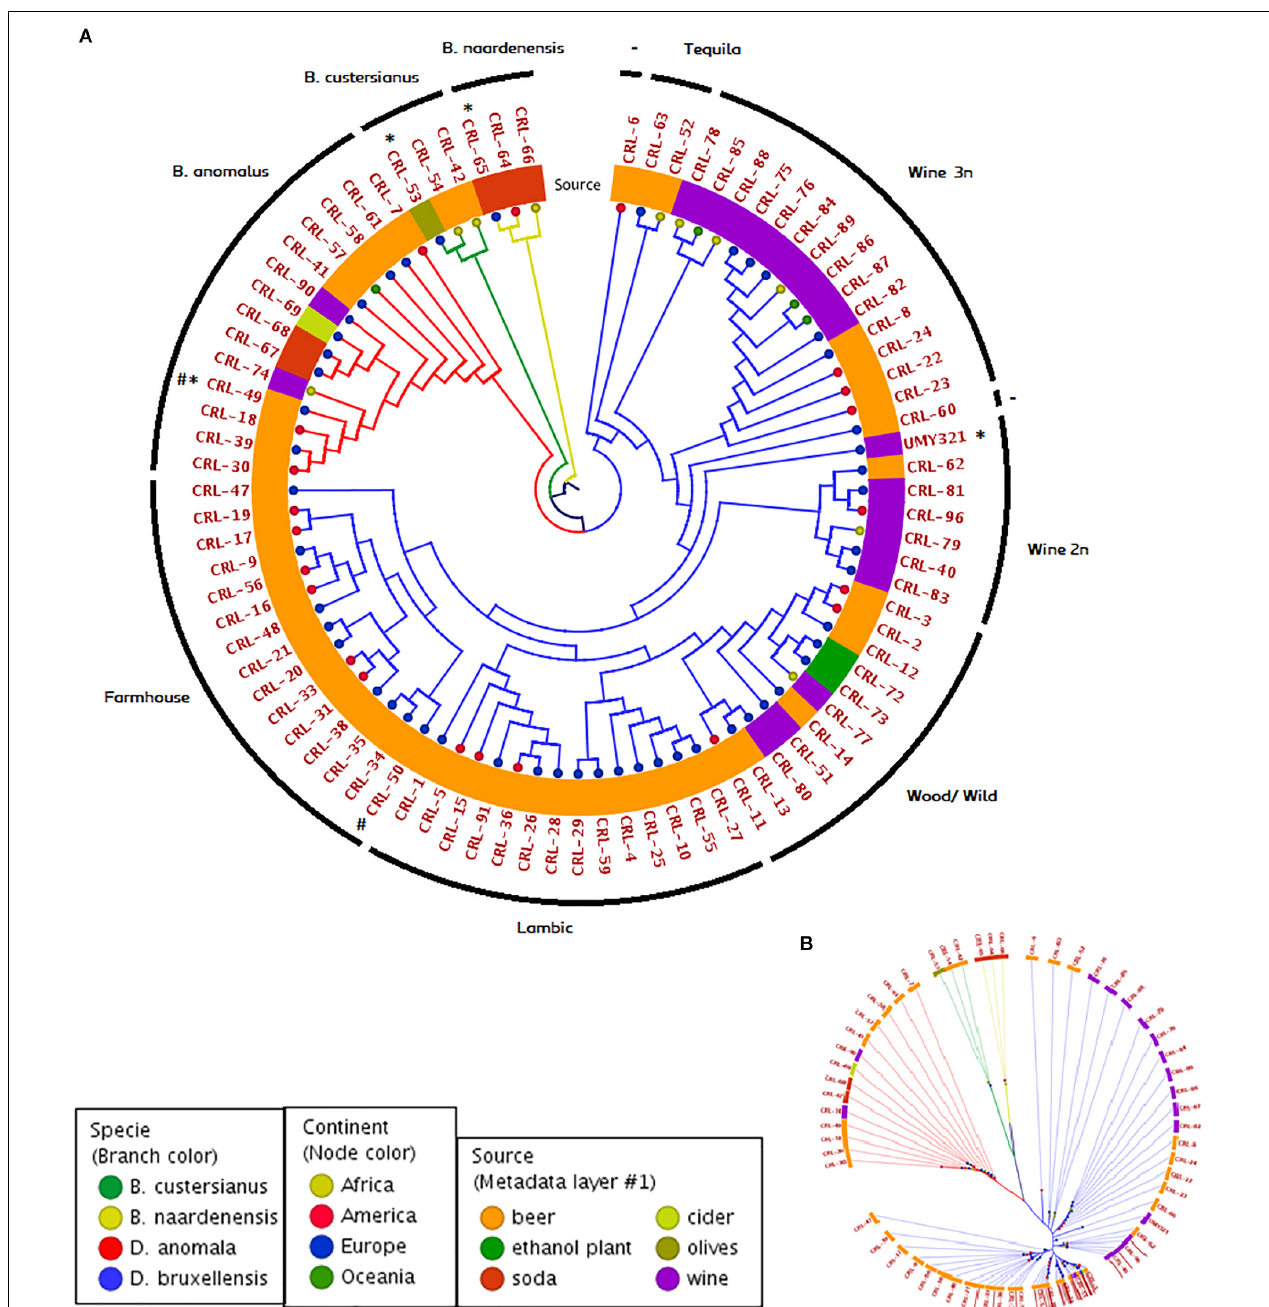
FIGURE 2 | Genomic phylogeny of Brettanomyces population. (A) Circular claudogram of 84 Brettanomyces species included in this study. Phylogenetic tree was produced by comparison of the predicted proteins in the whole genome of each strain. Strains used as reference genome are marked with ( ∗ ) Old CRL isolates are marked with (#). Branches are colored according to species, tree nodes according to continent of origin, and metadata layer is colored according to substrate of isolation. Yeasts have been grouped in different genetic clusters according to its location in the tree and genetic cluster names are indicated in the external circle. (B) Same phylogenetic tree in radial form. Branch length and separation displays genomic divergence between Brettanomyces